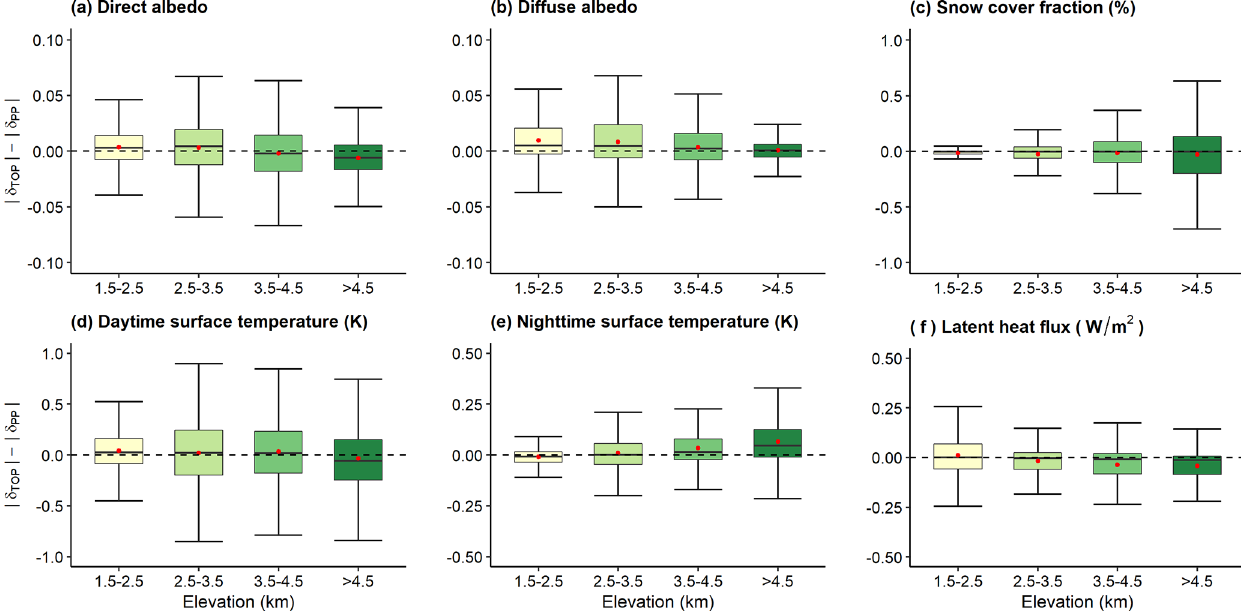
Figure 10. Boxplots of the differences in bias for TOP and PP ( | δ TOP | – | δ PP | ) with respect to MODIS data for (a) direct albedo, (b) diffuse albedo, (c) snow cover fraction, (d) daytime surface temperature, (e) nighttime surface temperature, and (f) latent heat flux in winter at four different elevation bands. Red points represent the mean values.